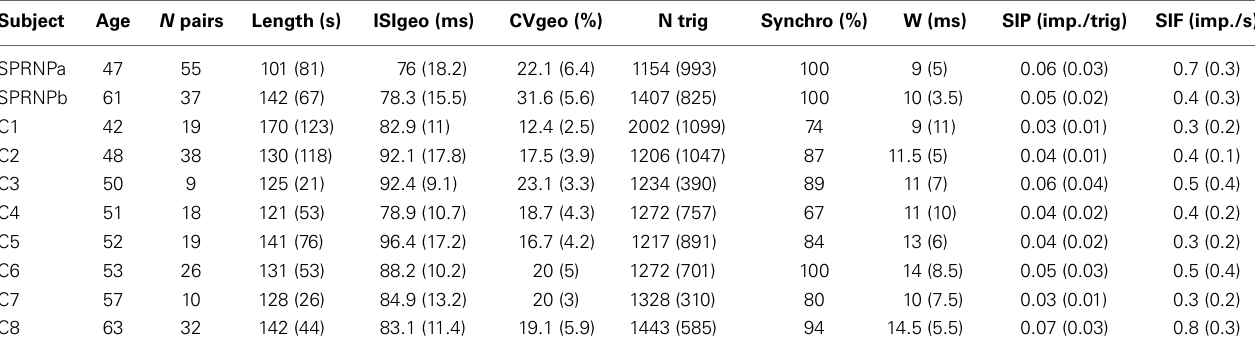
Table 1 | Characteristics of MU firing